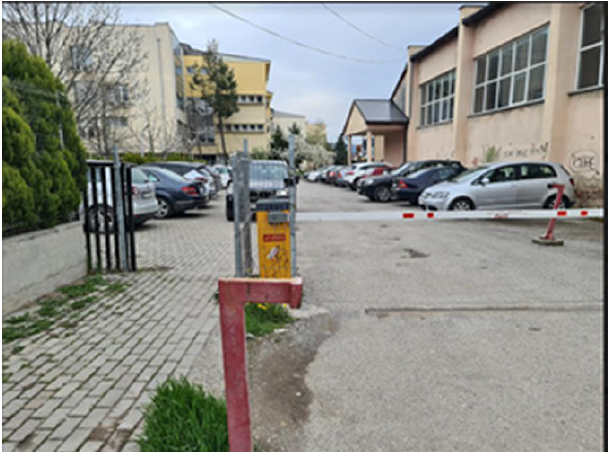
Fig. 3. Parking of vehicles with entry-exit